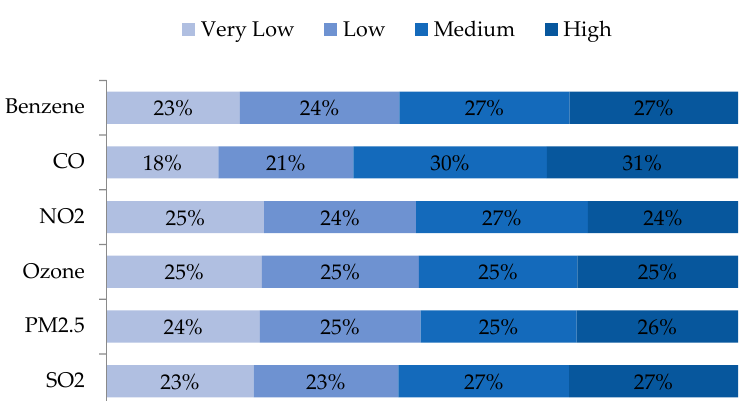
Figure 10. Distribution of exposure category based on WA metrics, for all observations with ambient air measurements indicating ‘High’ exposure, by pollutant. 4. Discussion Recent Pennsylvania-area studies using WA metrics as a proxy for URD exposure have reported statistically significant associations between URD and preterm birth [13]; asthma exacerbation [12]; and sinus symptoms, migraine, and fatigue [14]. Although the potential for measurement error and exposure misclassification was acknowledged in these studies, neither the extent to which this may be occurring nor the potential impact on resulting effect estimates have been quantitatively assessed. In our analysis, we did not validate WA metrics using Pennsylvania air monitoring data as a gold standard, nor did we directly evaluate whether studies using WA metrics produced reliable health risk estimates. Rather, we addressed a more basic point—whether these calculated exposure estimates agreed with those from air sampling data, and therefore, could be considered suitable surrogates of exposure when air measurement and/or detailed modeling data are unavailable. The question we essentially asked was, if these monitoring sites were instead a sample of epidemiology study subjects’ homes with monitors placed outside the front door, how well does the categorization of exposure agree between the two methods? We found that they did not agree well at all with the